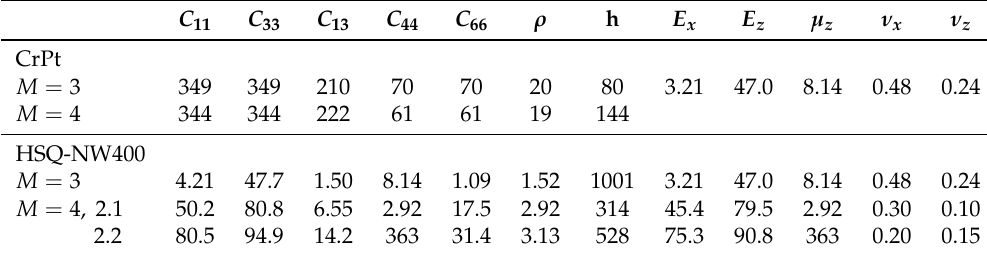
Table 3. Effective parameters of the CrPt coating and HSQ-NW400 composition obtained for the sample shown in Figure 2 within the 3-layer ( M = 3) and 4-layer ( M = 4) models (“ pyramidal ”